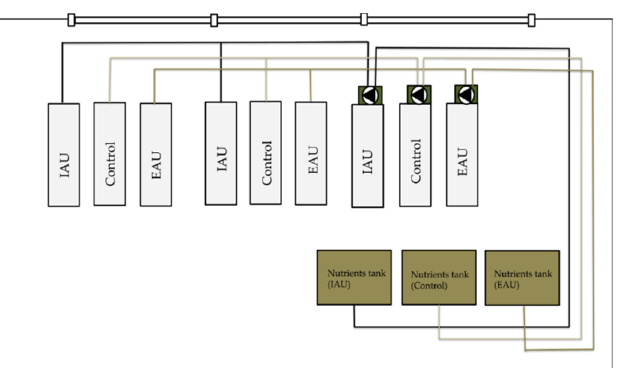
Figure 1. Scheme of the hydroponic cabin 1.04. Bright grey rectangles represent plant tables, green rectangles represent sump tanks, and brown rectangles represent nutrient tanks. Black triangles represent pumps; “Control”, control groups, “IAU”, groups of intensive aquaculture unit, “EAU”, groups of extensive aquaculture unit.